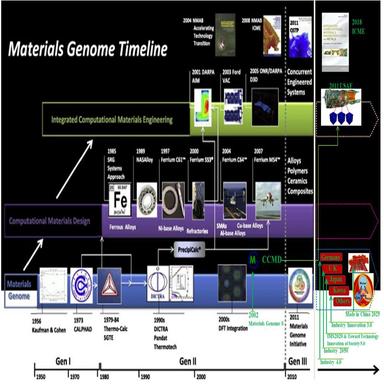
Materials Genome Technology Timeline. The original image described by Prof. G. B. Olson is reproduced from with the permission by Elsevier (License # 4457340843848). The recent successful case study of ICME labeled as 2011USAF is contributed by Dr. Craig Przybyla (Case # 88ABW-2011-2226) at the website of CCMD (Center for Computational Materials Design). The birth of Materials Genome®, the worldwide projects/strategies related to MGI/ICME, and the recent released ICME book are highlighted in t